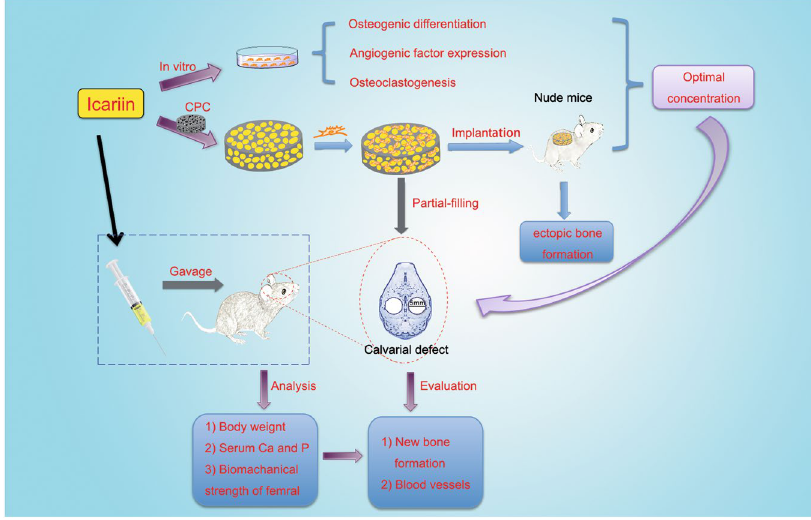
Figure 9. Schematic diagram of depicting the conceptual